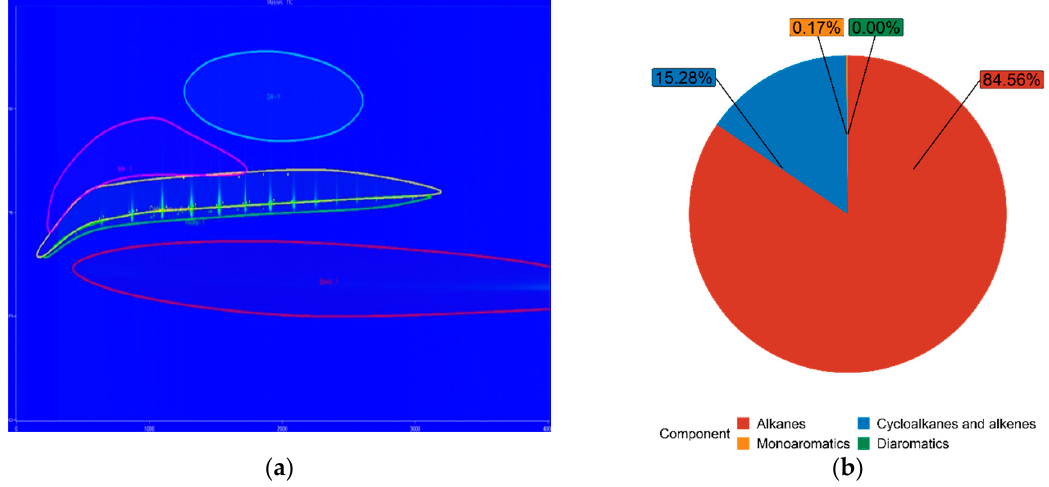
Figure 17. ( a ) Output of GC × GC-TOFMS for pure FT − diesel; ( b ) hydrocarbon composition of pure FT − diesel.